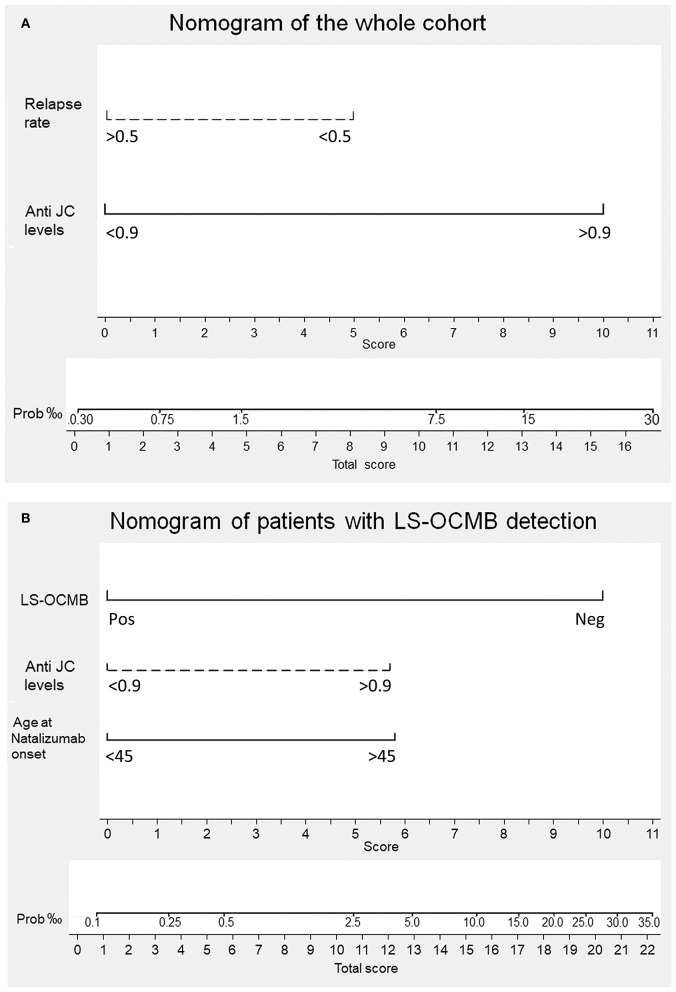
Nomogram for predicting progressive multifocal leukoencephalopathy (PML) onset in individual MS patients. The multivariate logistic regression analysis assigns a score to every variable included in the minimal model. The sum of the scores obtained by a patient is interpolated in the total score point-probability line at the bottom of each nomogram and gives the individual PML risk. (A) PML risk in the total cohort. Having a relapse rate lower than 0.5 gives a score of 5 and showing anti-John Cunningham virus antibody levels (anti-JC levels) higher than 0.9 provides a score of 10. Individual patient scores range from 0 to 15 and their PML risk from <1/3,300 to 1/50, respectively. (B) PML risk in the patients with lipid-specific oligoclonal IgM band (LS-OCMB) detection. Being negative (Neg) for LS-OCMB gives a score of 10. Showing anti-JC levels higher than 0.9 provides a score of 5.75. Being older than 45 years gives a score of 5.75. Individual patient scores range from 0 to 21.5 and their PML risk from <1/10,000 to 1/30, respectively.